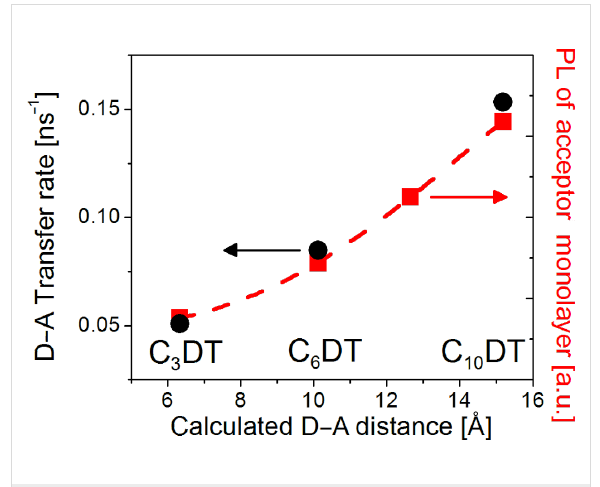
Figure 4: Energy transfer rates in the donor–acceptor NP bilayer (black) and normalized PL intensity from monolayers of acceptor NPs covered with various DT linkers (red) as a function of the linker length. The dashed red curve is the fit of the acceptor PL data to Equation 2 ( β = 0.42 Å − 1 , with a coefficient of determination of: R 2 = 0.99991 and a confidence level of parameters of